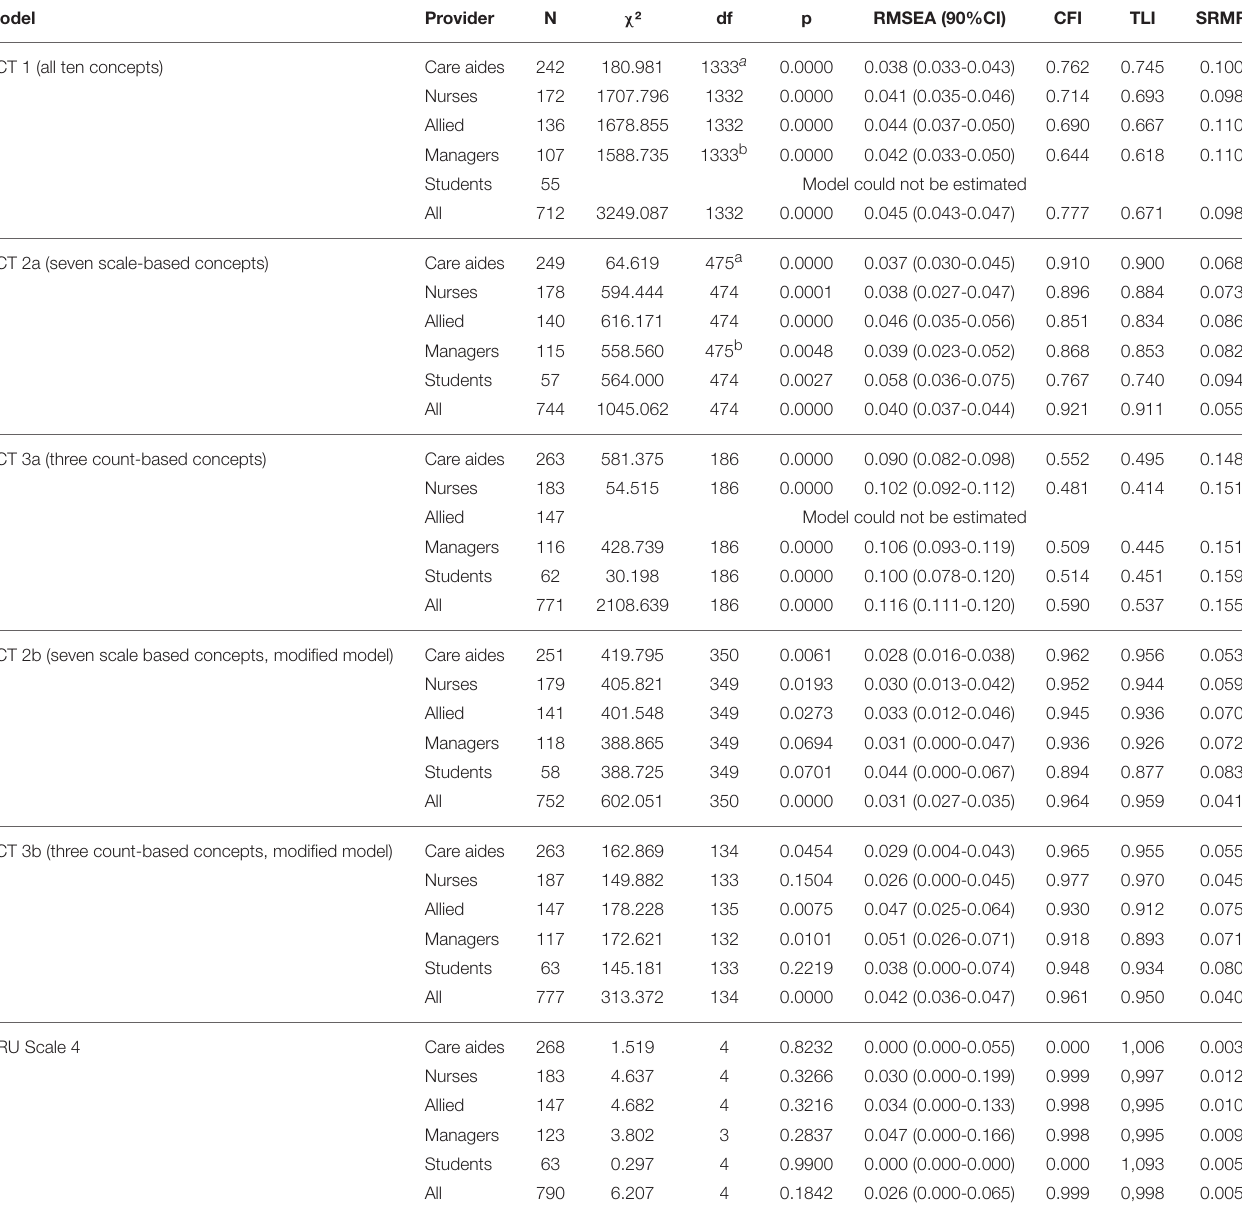
TABLE 7 | Model fit indices of the ACT and CRU Scale factor